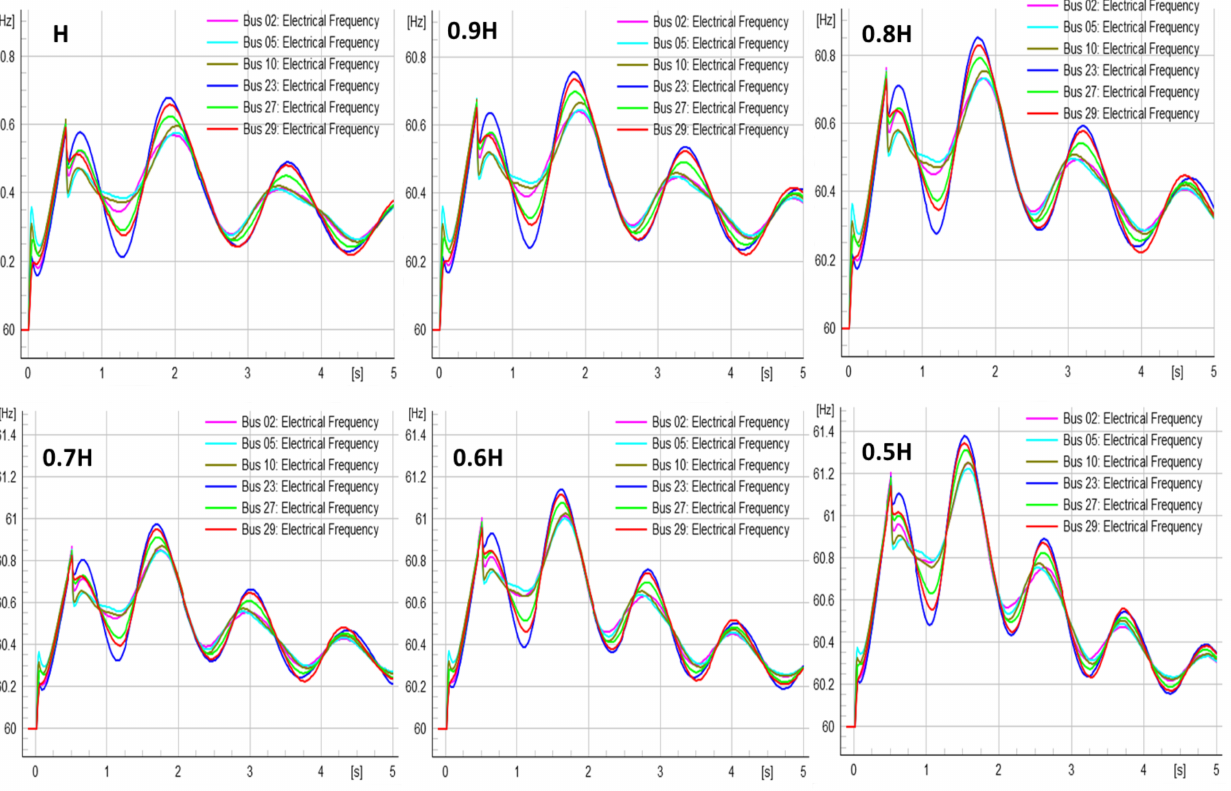
Figure 4. Electrical frequency (in Hz) at buses with different generator inertia constants.